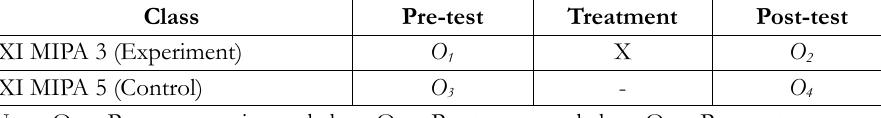
Table 1. The difference in treatment between the experimental class and the control